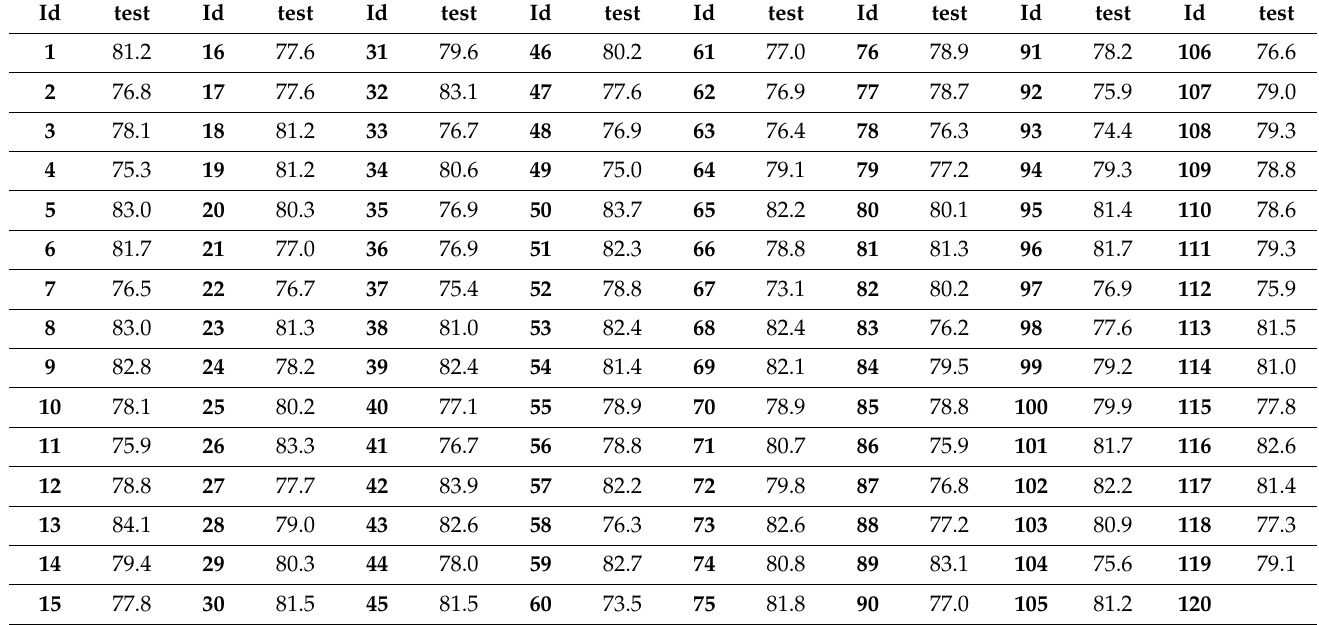
Table 6. Error computation based on the percentage of correctly predicted rainy or non-rainy days, testing value in percentage ( test ), for each weather station identified by the id code ( Id ).